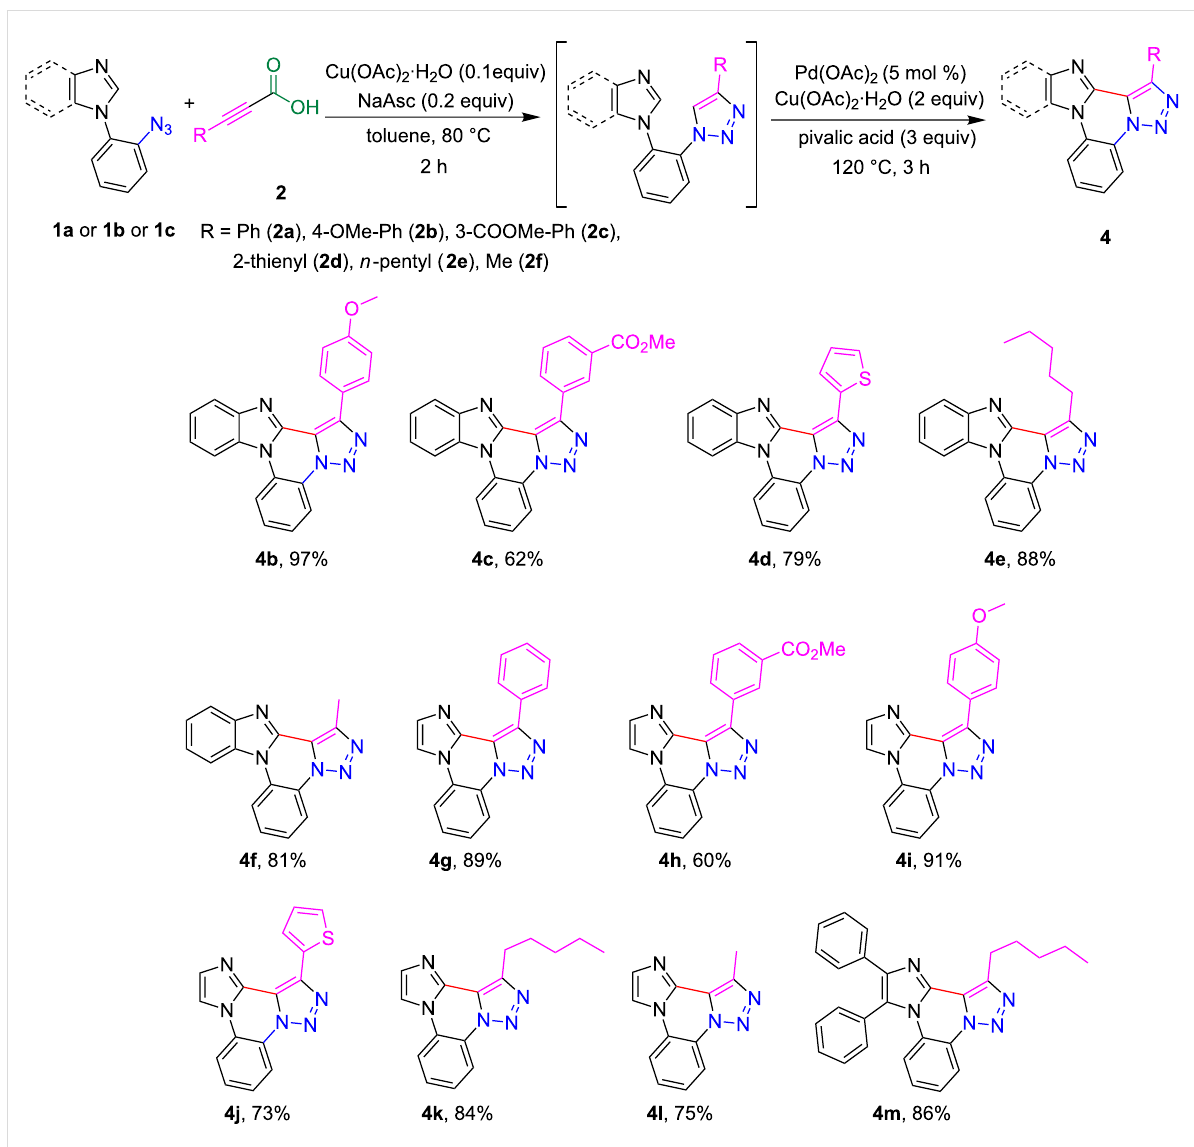
Scheme 4: Synthesis of fused polycyclic triazole analogs 4